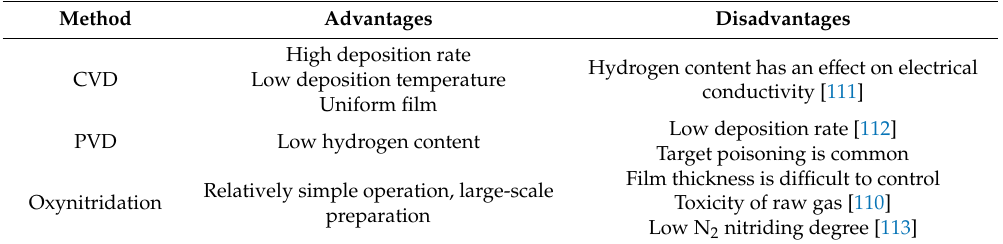
Table 3. Preparation methods of SiN x O y film.